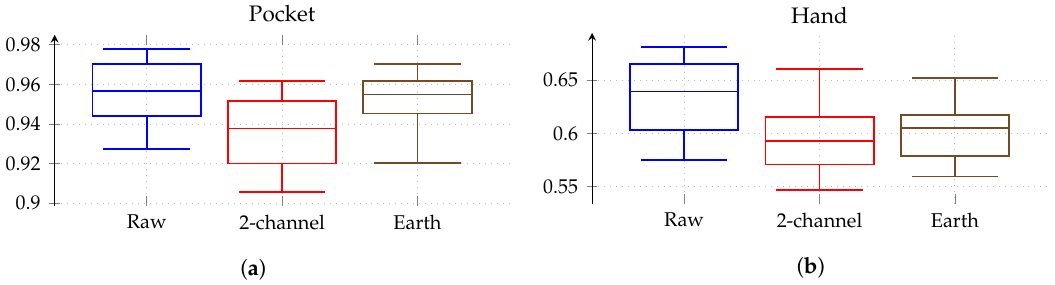
Figure 19. Statistical evaluation of the accuracies across all tested configurations for raw acceleration, two-channel acceleration, and acceleration transformed into the underspecified earth coordinate system for both pocket-case ( a ) and hand-case ( b ).